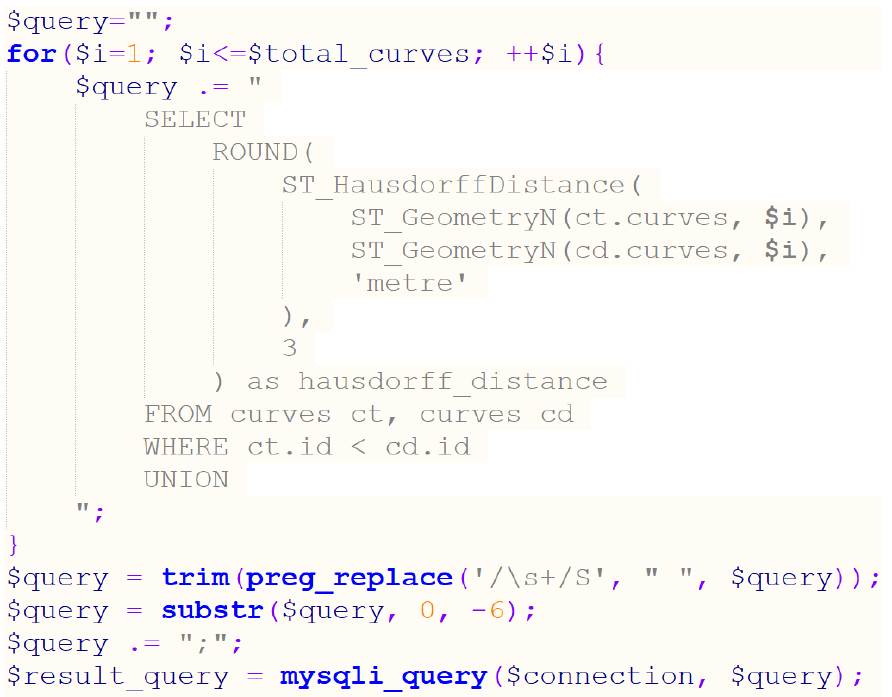
Figure 10. Implementation of the query in PHP and SQL to obtain the Hausdorff distance among features of different geospatial objects.